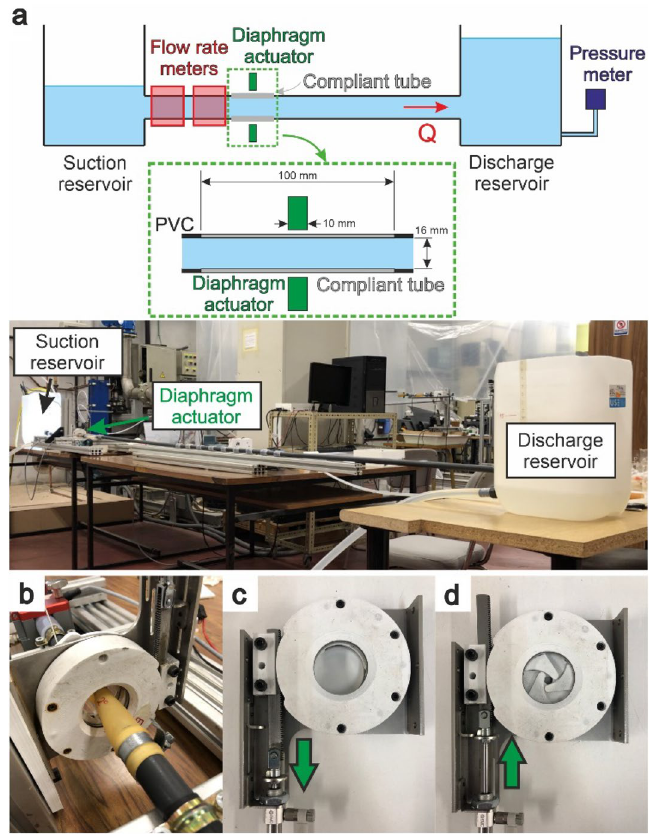
Figure 3. ( a ) Pure asymmetric test rig with λ = 4.33 ( b ) diaphragm shutter actuator mounted in the test rig, ( c ) diaphragm shutter open, ( d ) diaphragm shutter